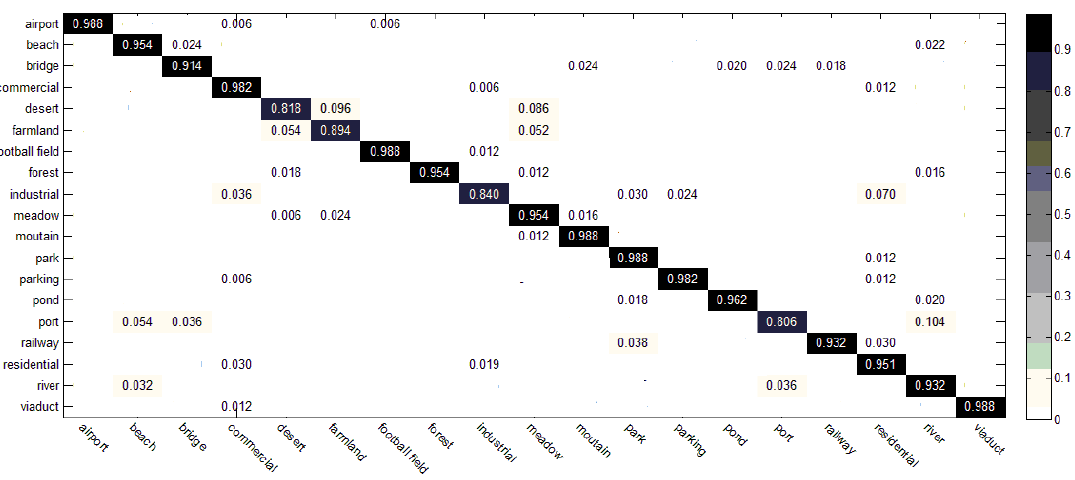
Figure 13. Confusion matrix for the proposed algorithm using WHU-RS land-use dataset.